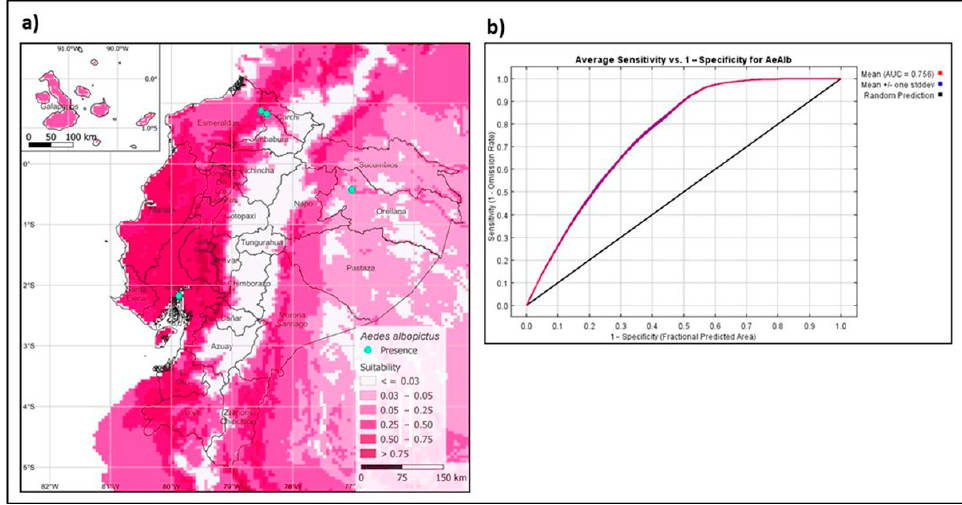
Figure 5. Maximum entropy models for the present distribution of Aedes albopictus . ( a ) Spatial distribution of Ae. albopictus in Ecuador. ( b ) Receiver operating characteristics with AUC value.